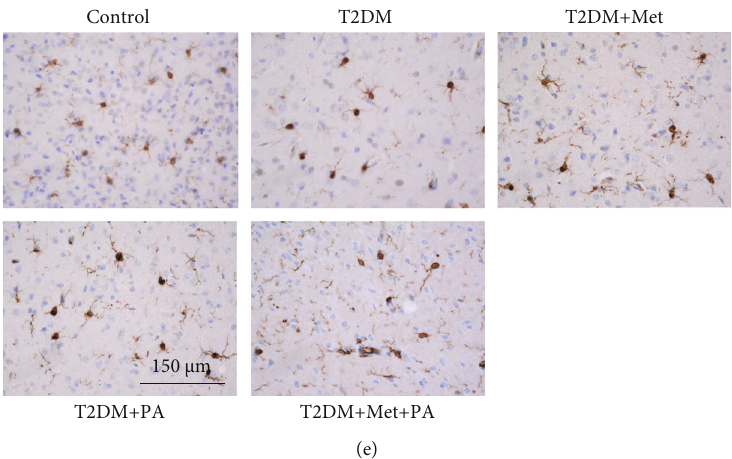
Figure 8: E ff ects of metformin and PA treatment on the content of microglial marker Iba1. Immunoblotting analysis of the Iba1 in rat VMH: (a) representative immunoblots are shown and quanti fi ed using tubulin as a loading control for hypothalamus lysates. The bar graphs of the (b) Iba1 protein level are presented as means ± SEM ( n = 6/group ). Quantitative RT-PCR of the (c) Iba1 in rat VMH: data were normalized to β -actin and pooled from three independent experiments ( n = 6 rats/group). Immunocytochemical analysis of the Iba1-positive VMH cells: representative (d) histogram and (e) images of representative VMH sections showing the Iba1-positive microglial cells are shown. DAB staining was used to visualize the Iba1-positive microglial cells; Hematoxylin Gill was used for nuclear staining. Scale bars indicate 150 μ m (magni fi cation × 400). All data are shown as means ± SEM ; ∗ p < 0 : 05 vs. control, ∗∗ p < 0 : 05 vs. T2DM, # p < 0 : 05 vs. metformin administration, and @ p < 0 : 05 vs. PA